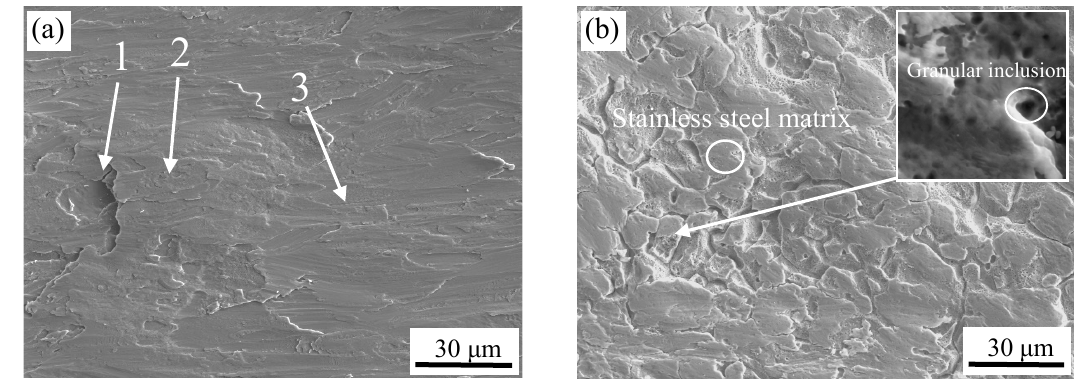
Figure 3. Stainless steel surface micrographs by different surface treatment. ( a ) brush grinding, and ( b ) pickling. Table 2. Wavelength dispersive spectroscopy (WDS) analysis of the three points identified in Figure 3a. Position 1 O/at %